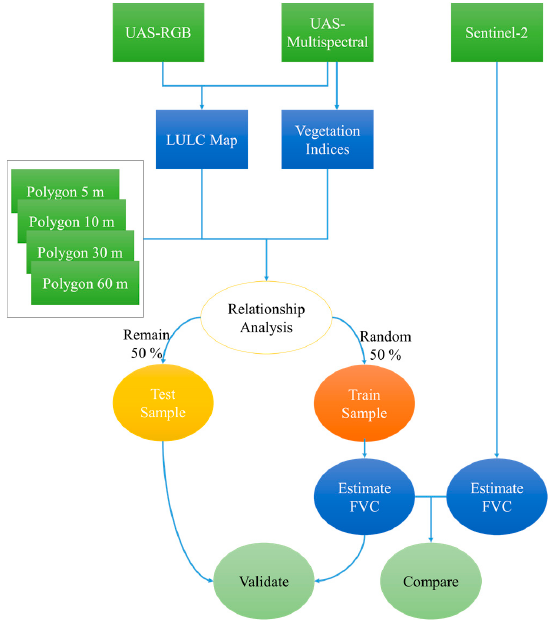
Figure 3. Overall flowchart of the